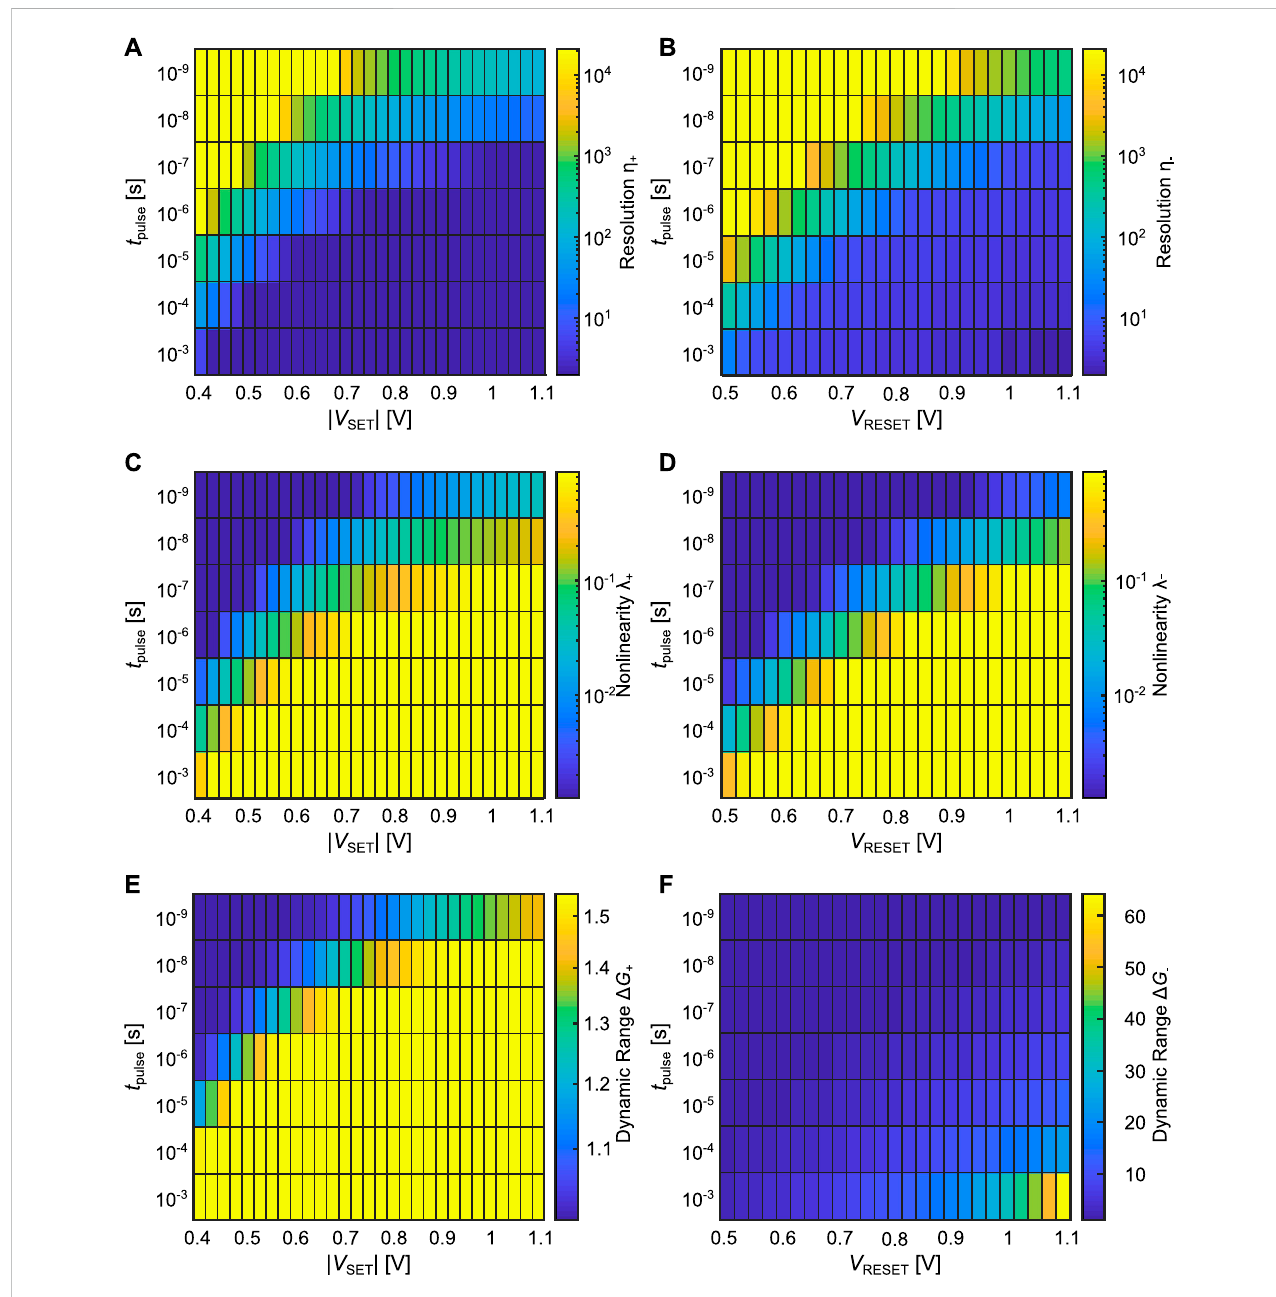
FIGURE 6 Parameter study involving the variation ofthe pulse width and pulsevoltage and its effect on the performance metrics: Resolution η ± for (A) potentiation and (B) depression, non-linearity λ ± for (C) potentiation and (D) depression, dynamic range Δ G ± for (E) potentiation and (F) depression. The results were obtained by fi tting the analytical equations in Table 1 to the deterministic simulation